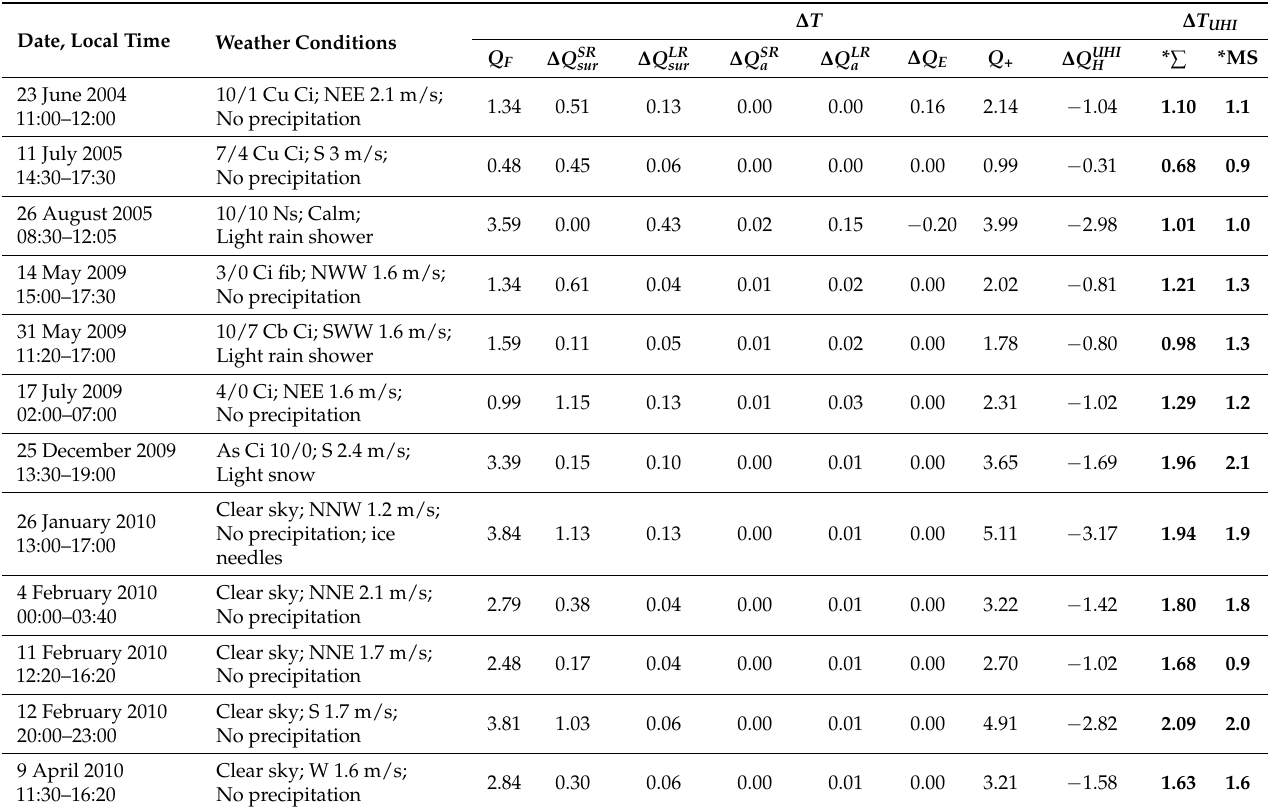
Table 6. Calculated contributions of different factors to the UHI formation ( ◦ C) for the measurements of the mobile station.